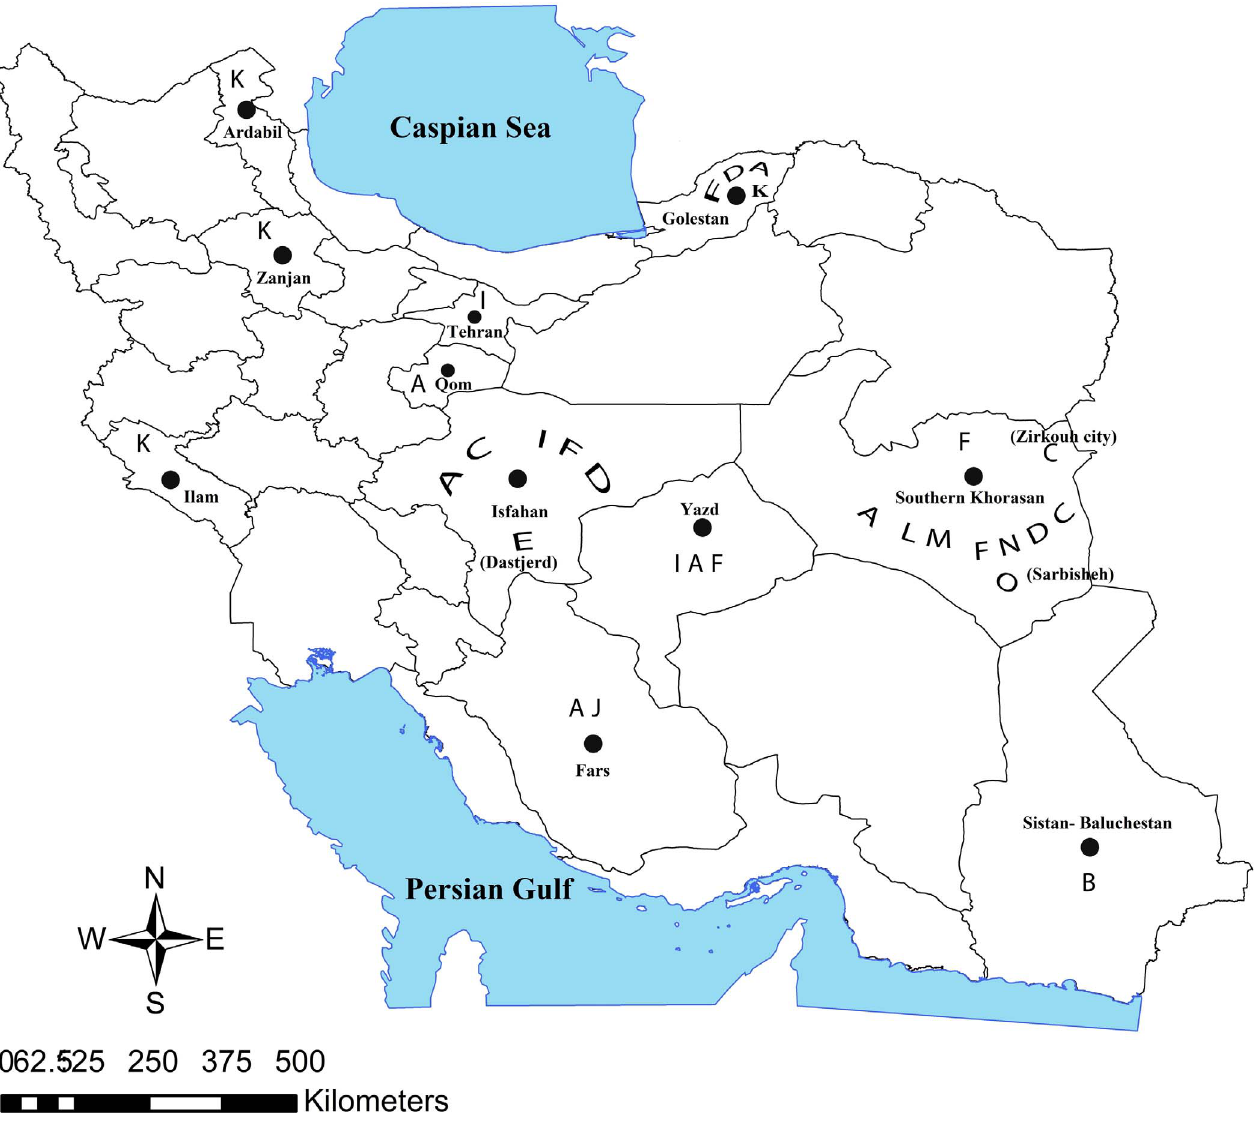
Fig. 3. Distribution of anthroponotic cutaneous leishmaniasis in vectors in Iran; A : Phlebotomus papatasi , B : Phlebotomus Salehi , C : Phlebotomus sergenti , D : Phlebotomus caucasicus , E : Phlebotomus mongolensis , F : Phlebotomus anderjevi , I : Phlebotomus ansarii , J : Phlebotomus alexandri , K : Phlebotomus per fi liewi , L : Phlebotomus jacusieli , M : Sergentomyia dentata , N : Sergentomyia sintoni , O : Sergentomyia clydei